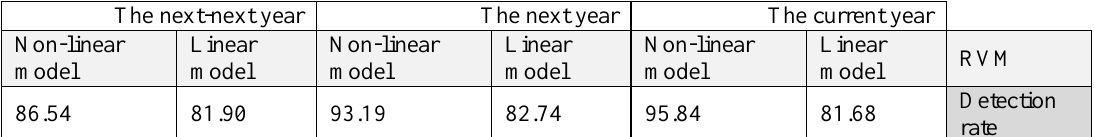
Table 5: The mean of RVM Linear and Non-Linear Model Detection Rate for predicting the Bankruptcy of companies for training data.